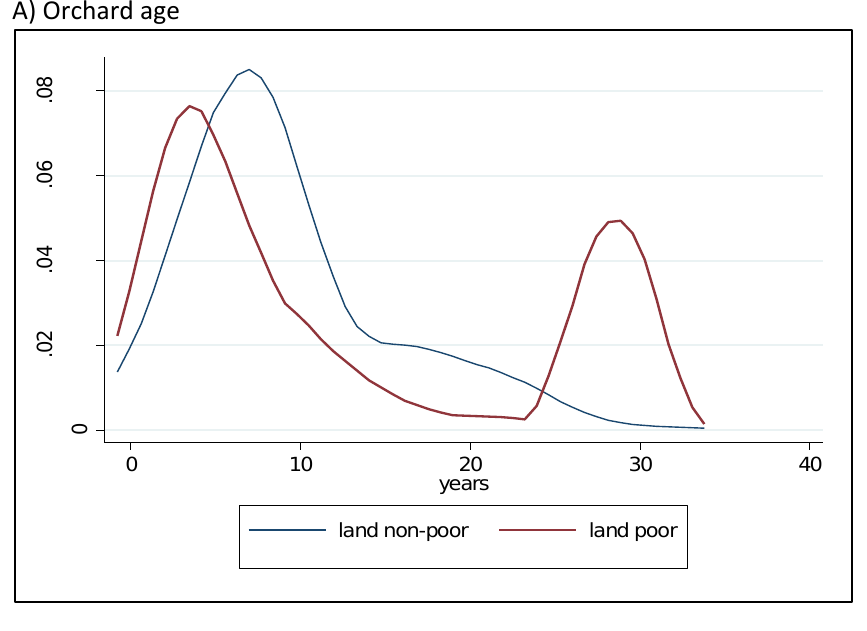
Figure A1.4. Nonparametric density estimates for orchard age and fallow duration for initial land non- poor and poor households, San Jose,